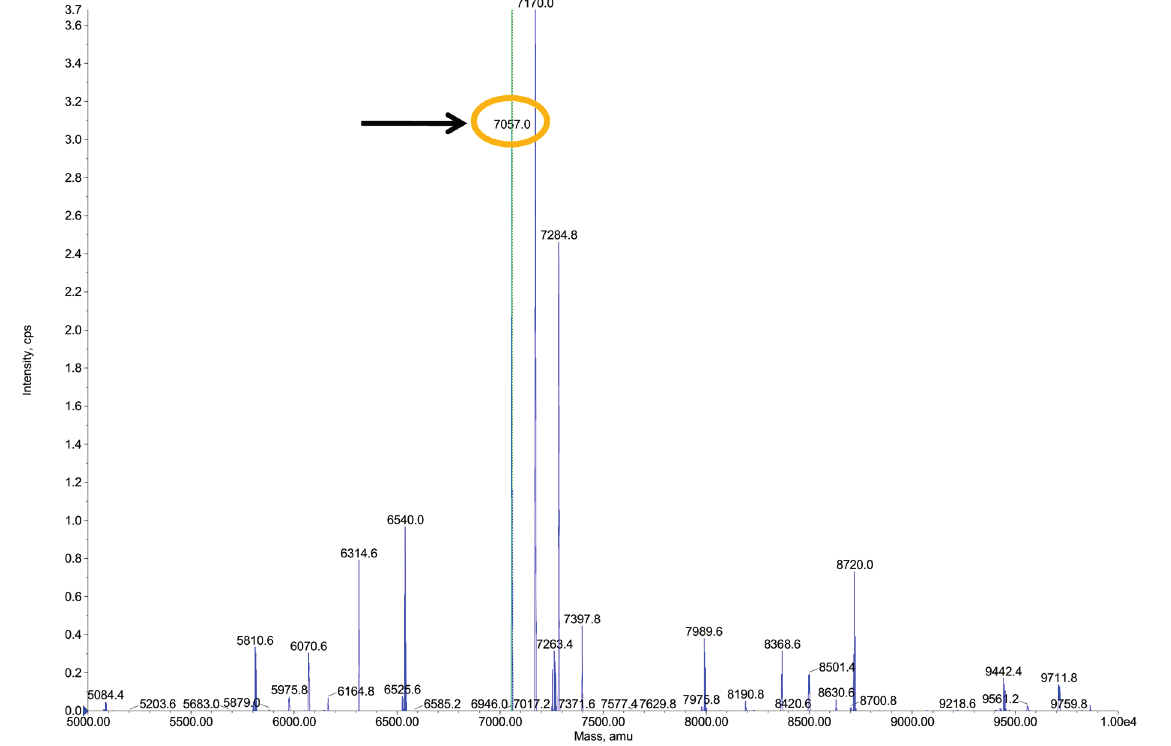
Figure 3. HPLC-ESI-QTOF analysis of SN2. The expected mass of 7057 Da was